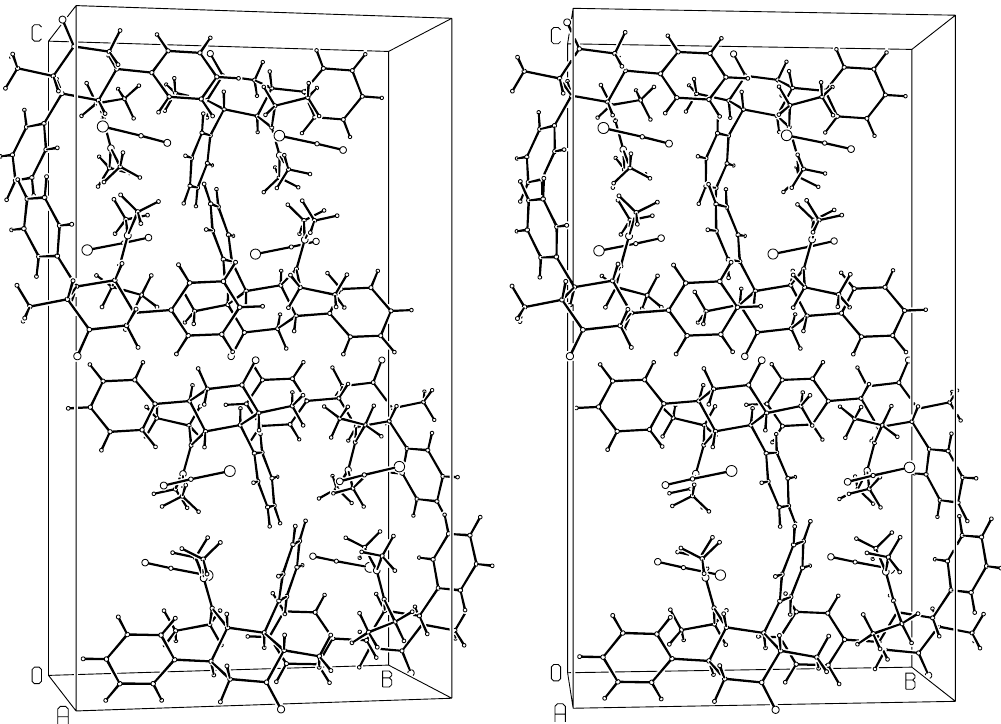
Figure 3 . Stereoscopic ORTEP [7] plot of the packing of 16 . The atoms are drawn with arbitrary